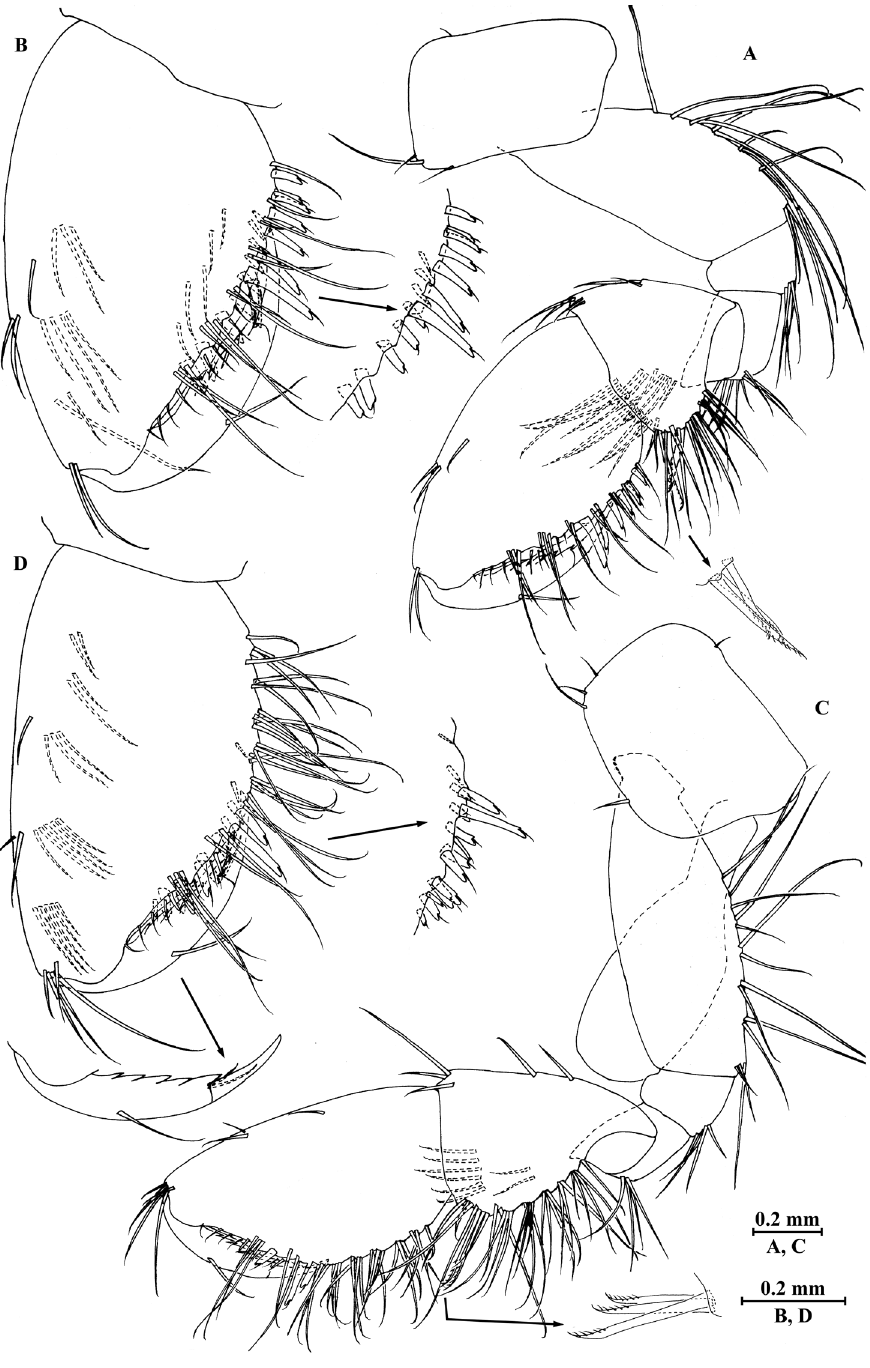
Figure 3. Pseudocrangonyx elegantulus sp. n., female holotype. A gnathopod I B propodus of gnathopod I C gnathopod II D propodus of gnathopod